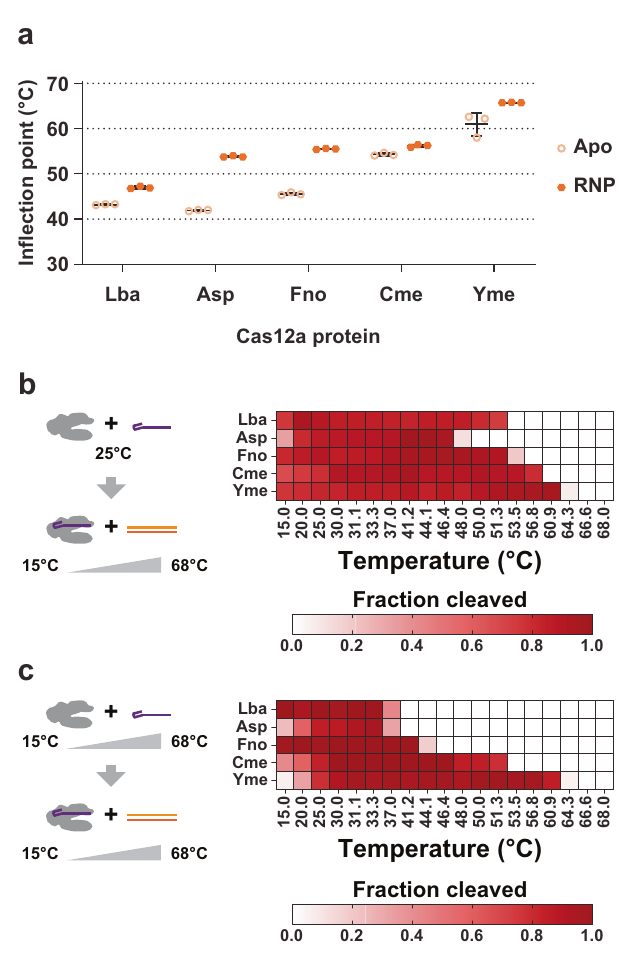
Fig. 2 Cas12a thermostability and dsDNA target cleavage activity. a Thermal stability of Cas12a proteins without crRNA (apo) or loaded with crRNA (RNP). Protein unfolding was measured with nano differential scanning fl uorometry (NanoDSF) over a temperature range from 20°C to 80°C. Fluorescence was monitored as temperature increased at a rate of 1°Csec − 1 . The in fl ection point of the fl uorescent curve is interpreted as the unfolding point of the protein. Data points collected from replicate experiments are plotted and error bars represent mean ±standard deviation. Raw traces of the fl uorescence data can be found in Supplementary Figure S2. The on-target double-stranded DNA (dsDNA) cleavage activities of Cas12 RNPs was measured using in vitro assays containing fl uorophore-labeled dsDNA target substrates. Cas12a protein was incubated with crRNA at either 25°C ( b ) or at varying temperatures ( c ) to form RNPs. RNPs formed at 25°C were then transferred to the indicated reaction temperature. A cleavage reaction was initiated by adding 5 ′ fl uorescein-labeled target DNA pre-incubated at the reaction temperature to the Cas12a RNPs. Cleaved fragments were quanti fi ed and the proportion of the substrate cleaved in each condition is represented in a heatmap where the intensity of the red color corresponds to the extent of target cleavage. Source data used to make the graphs are provided in Supplementary Data